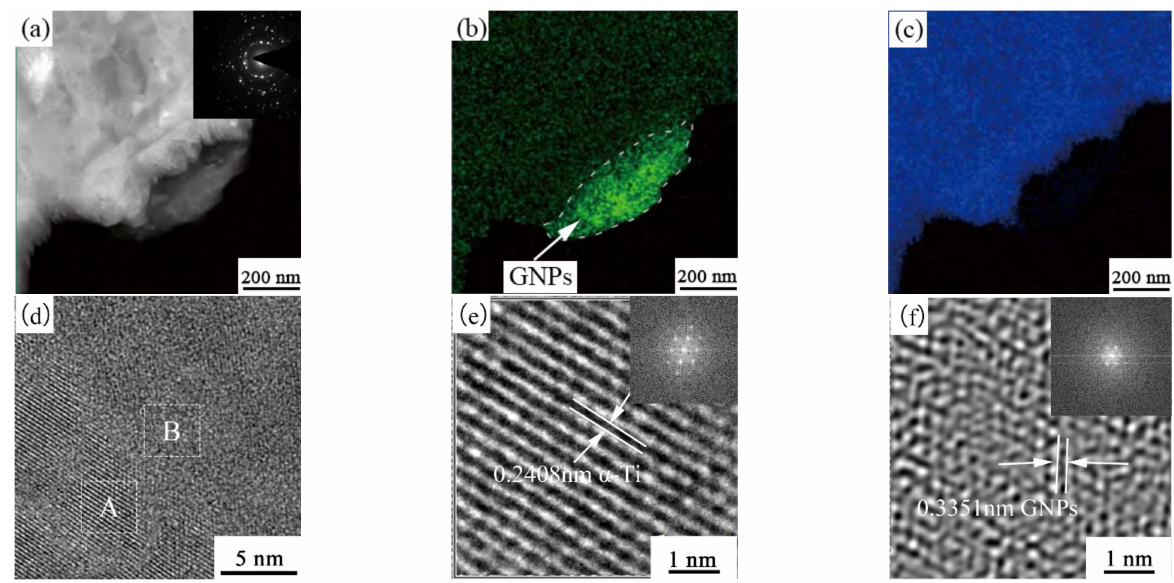
Figure 7. GNPs/TC11 composite interface combined with TEM images: ( a ) TEM diagram of GNPs/TC11 open field interface; ( b ) C element distribution map; ( c ) Ti element distribution map; ( d ) HRTEM diagram of GNPs/TC11 interface; ( e , f ) FFT and IFFT diagrams of rectangular frames A and B in ( d ),